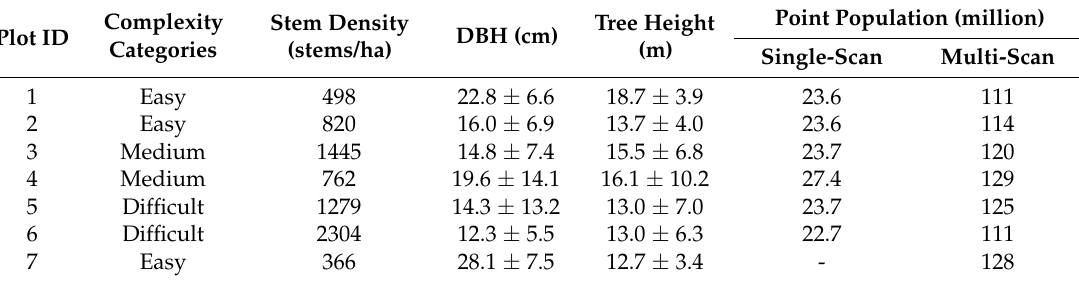
Table 1. Characteristics of the sample plots and the TLS datasets.